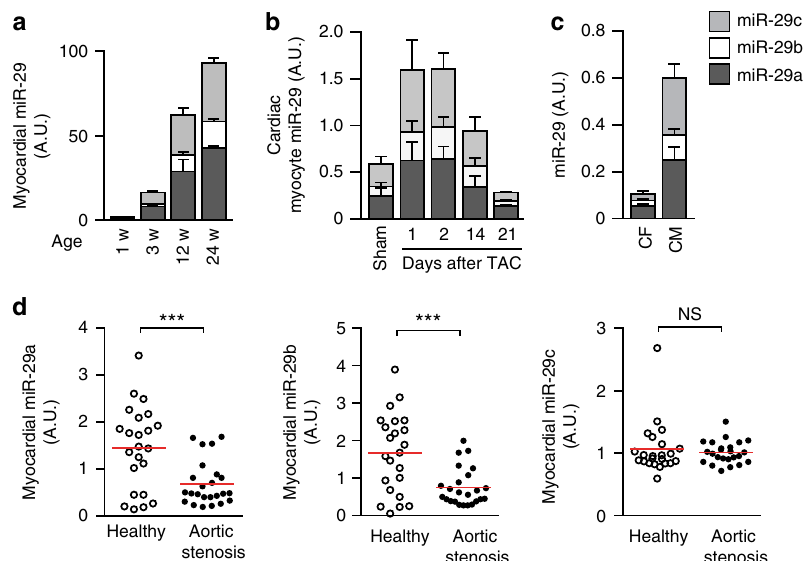
Fig. 3 Expression of miR-29 members in cardiac cells and their deregulation in disease. a – d Individual quanti fi cations (by qPCR) of miR-29 variants a, b and c in primary cardiac cells or in left ventricular myocardium. a Age-dependent cardiac expression of miR-29 variants in mice (w: week); n = 4 – 5 mice per group. b Endogenous levels of miR-29 family members in cardiac myocytes from mice 21 days after sham treatment or, for the TAC group, at denoted time points; n = 3 – 6 mice per group. c Endogenous levels of miR-29 family members in CM and CF freshly isolated from adult mouse myocardium; n = 12 – 13 independent cell isolations. d Quanti fi cation of miR-29 variants in human left ventricular myocardium from 23 healthy individuals or from 24 patients with aortic valve stenosis. All quantitative data are reported as means ± SEM. *** P < 0.001 calculated using Student ’ s t